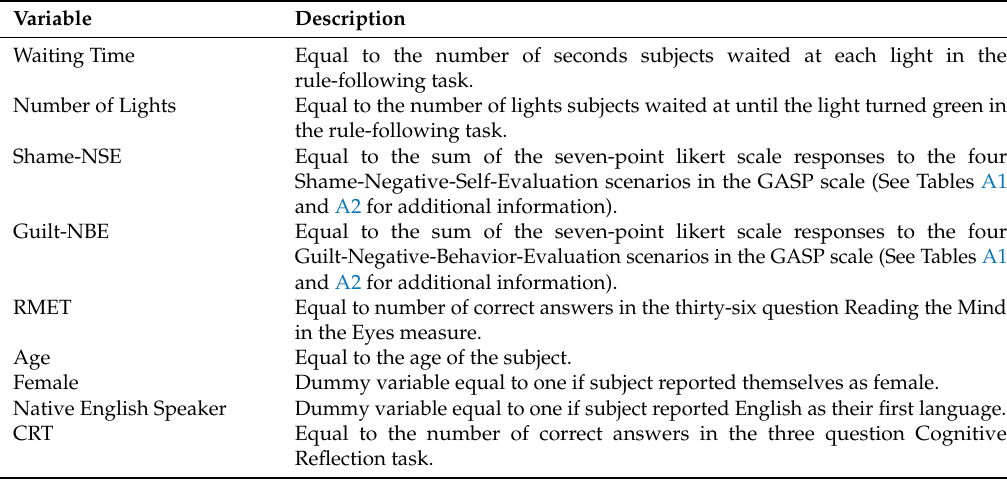
Table 1. Description of variables.